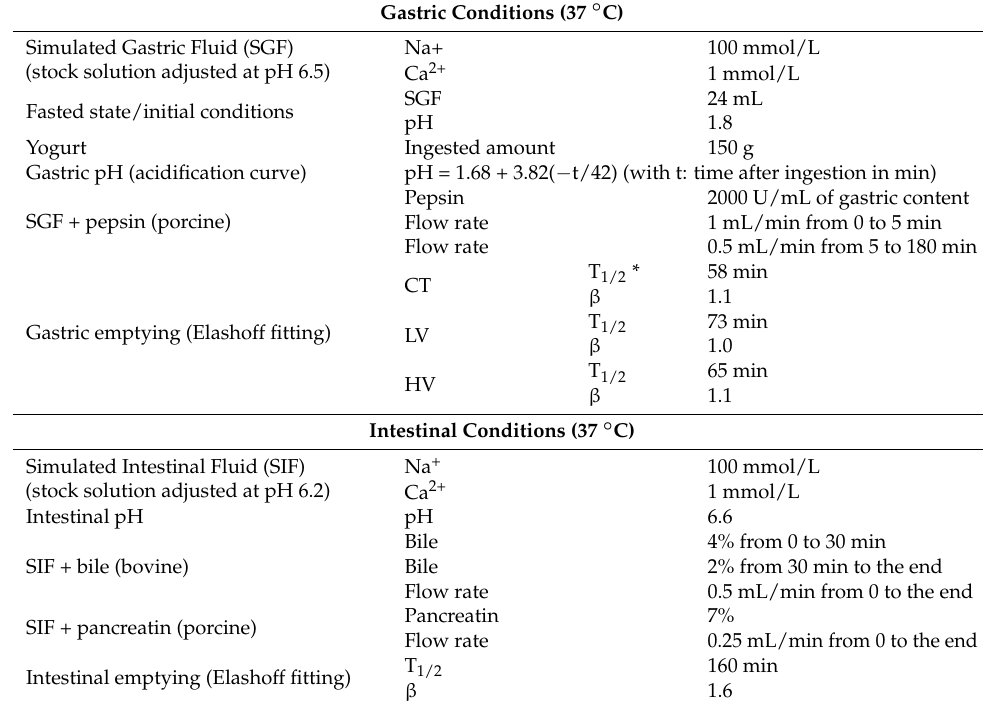
Table 3. Gastro-intestinal parameters for in vitro dynamic